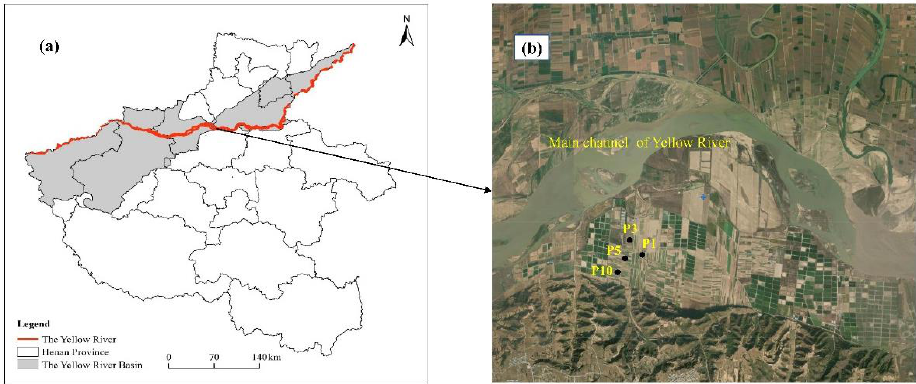
Figure 1. The experimental sitemap illustrating the location of Henan Province, China. ( a ) Gray area is the Yellow River basin and red line is the main channel of Yellow River. ( b ) The map demonstrates the sample sites in the floodplain of the Middle Yellow River; yellow points represent sample sites; pomegranate plantation for one year (P1), other names (P3; P5; P10) are in the same manner.